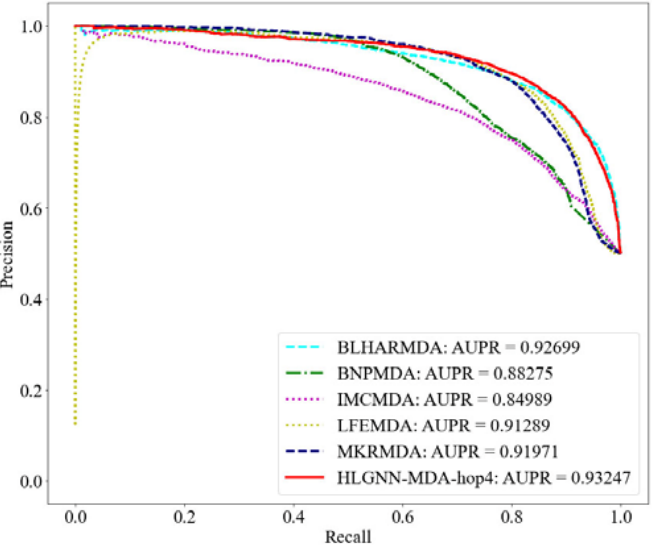
Figure 5. PR curve of HLGNN-MDA and state-of-the-art miRNA–disease association prediction al- gorithms. Table 1. Performance analysis of HLGNN-MDA and state-of-the-art miRNA–disease association prediction algorithms. The bold part indicates the maximum value in the corresponding column.